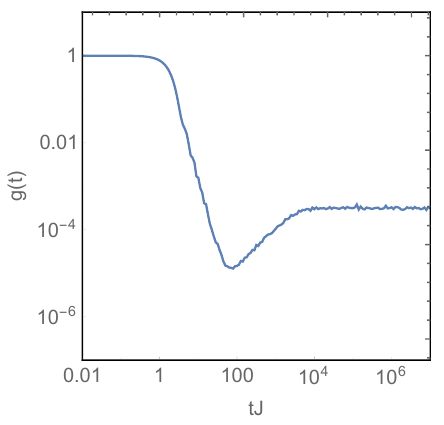
Figure 1 . Example of spectral form factor R 2 ( (cid:12); t ) in SYK model. We take (cid:12)J = 1 and N = 24 with 800 random